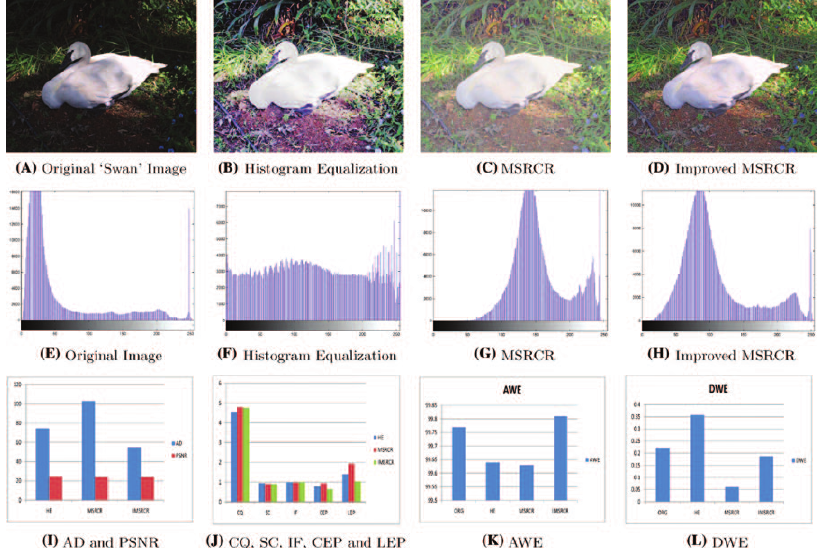
Figure 11. (Top) Image Enhancement Methods. (Middle) Histogram Plots: x -axis, Intensity Levels Ranging from 0 to 255; y -axis, Total Number of Pixels. (Bottom) Conventional Metrics and Proposed AWE and DWE Metrics. The “Swan” Image has been Downloaded from http://www.cs.huji.ac.il/ ∼